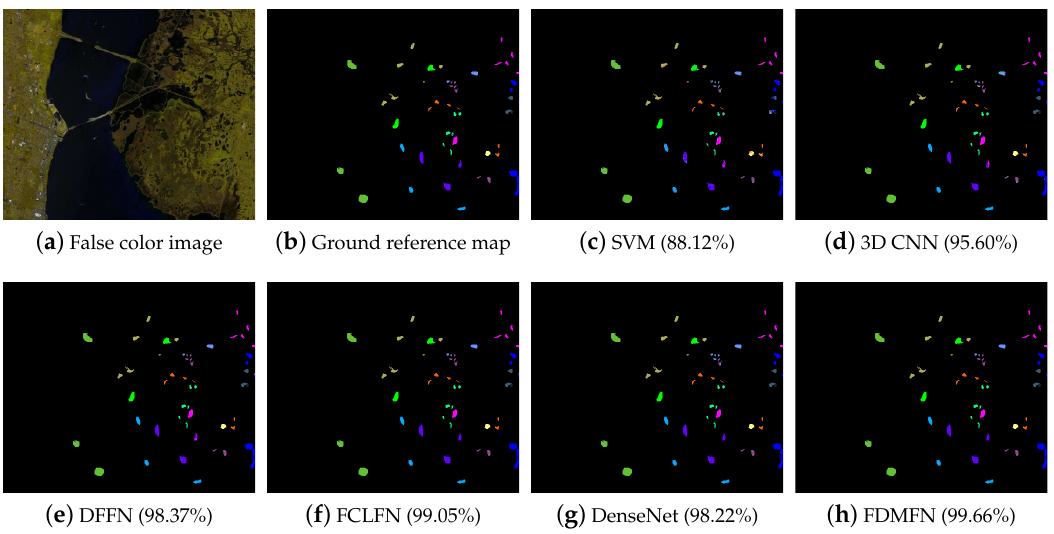
Figure 8. Classification maps and overall classification accuracies for the UH dataset.